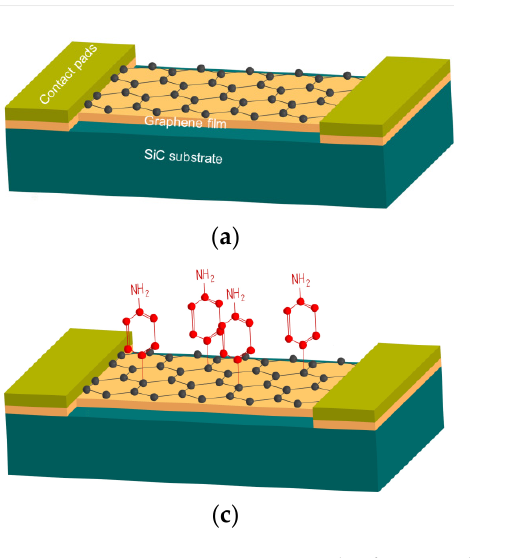
Figure 1. The functionalization of a biosensor based on graphene film on SiC substrate for influenza virus detection. ( a ) С hip with pristine graphene. ( b ) Formation of covalent bonds after deposition of nitrophenyl groups. ( c ) Reduction of the nitrophenyl groups to phenylamine groups. ( d ) Immobilization of influenza A (or B) virus antibodies.